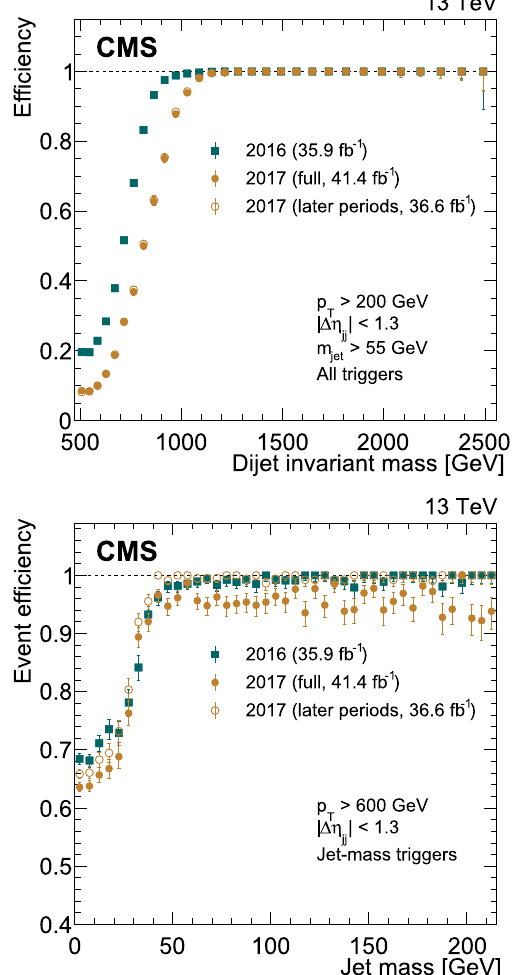
Fig. 3 The trigger efficiency as a function of the dijet invariant mass for a combination of all triggers used in this analysis (upper) and the event efficiency for either of the selected jets to pass triggers requiring an online trimmed mass of at least 30GeV as a function of the jet mass (lower). The solid yellow circles correspond to the trigger efficiencies for the full 2017 data set and do not reach 100% efficiency because the jet mass based triggers were unavailable for a period at the beginning of data taking (corresponding to 4.8fb − 1 ). The open yellow circles are the corresponding efficiencies excluding this period. The uncertainties shown are statistical only